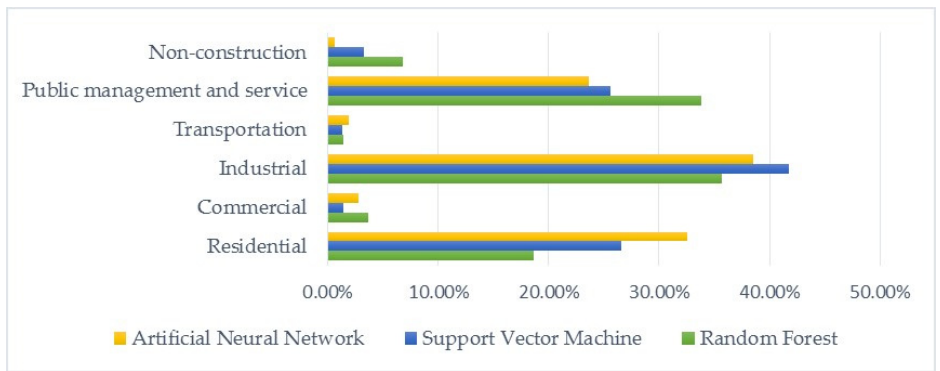
Figure 4. The area percentage of Level I land-use types in the mapping results.